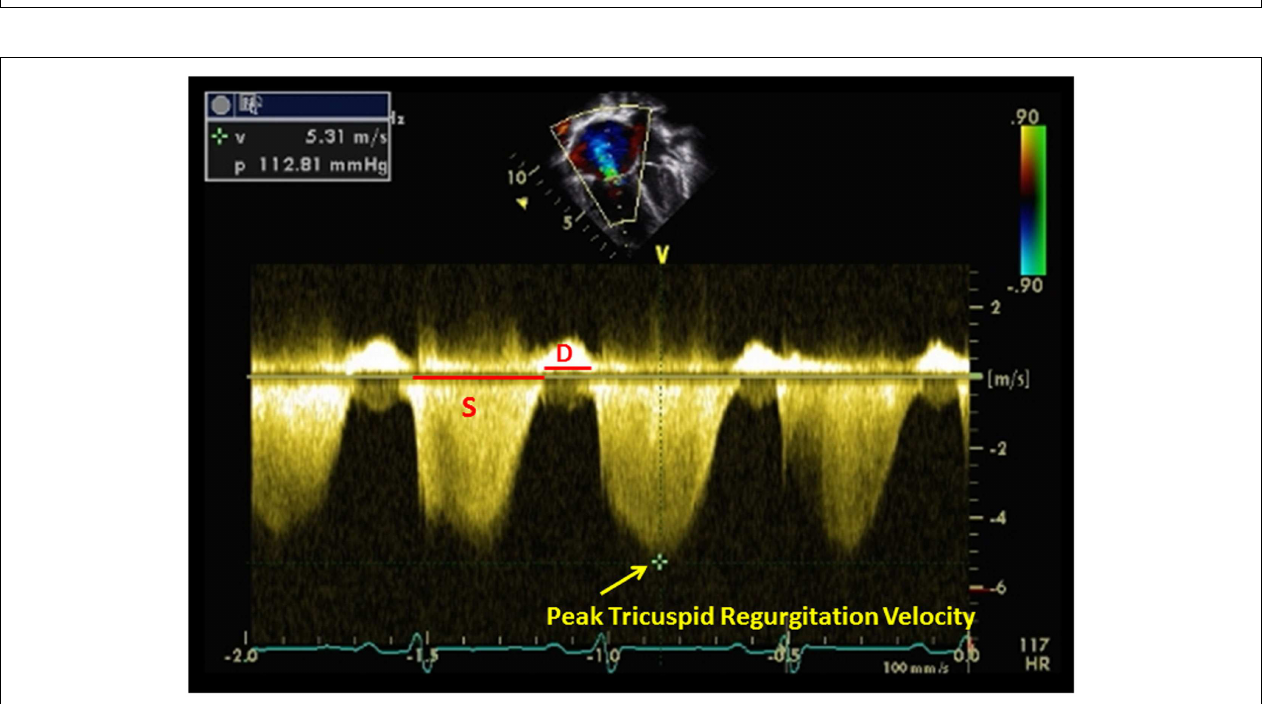
FIGURE 4 | Parasternal short axis view of the right and left ventricles at the level of the papillary muscles .The RV/LV ratio is derived from RV diameter and LV diameter at end-systole.